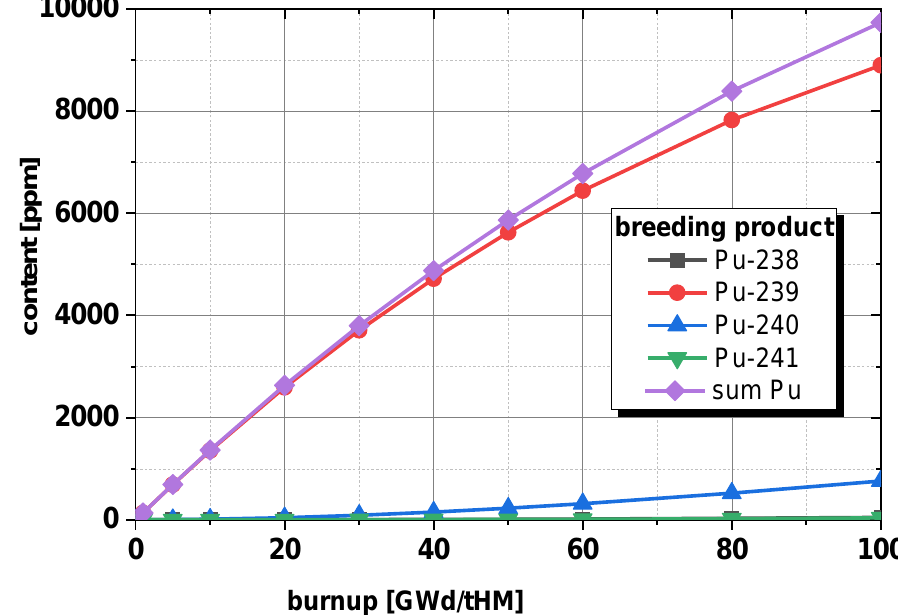
Figure 5. Accumulation of isotopes over burnup for selected leading breeding products.